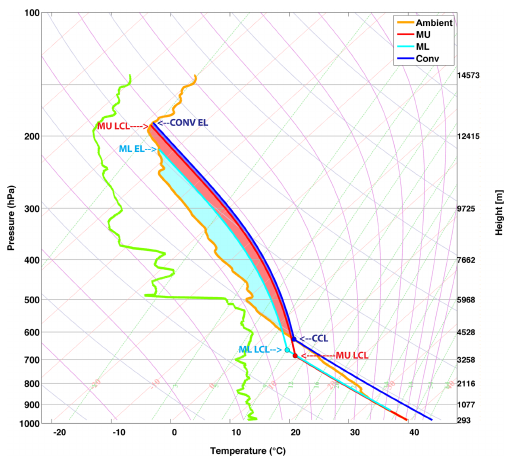
Figure 18. Analysis of lifted parcels, showing the most unsta- ble (MU), mixed-layer (ML), and convective (Conv) parcel trajecto- ries. The condensation levels and CAPE for each parcel is described in the